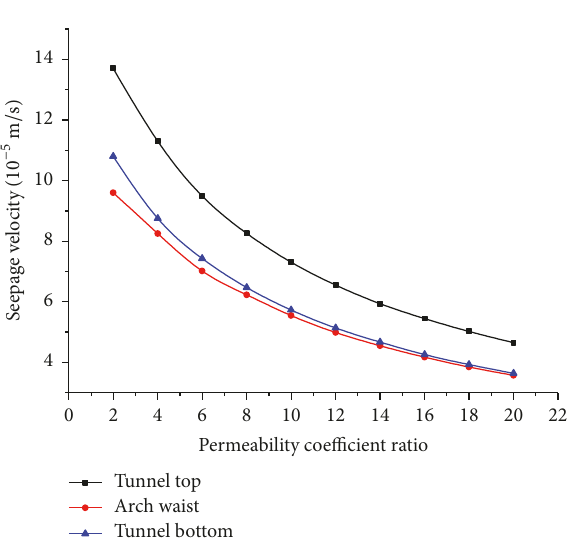
Figure 13: Relationship of pore water pressure and permeability coefficient of grouting circle.